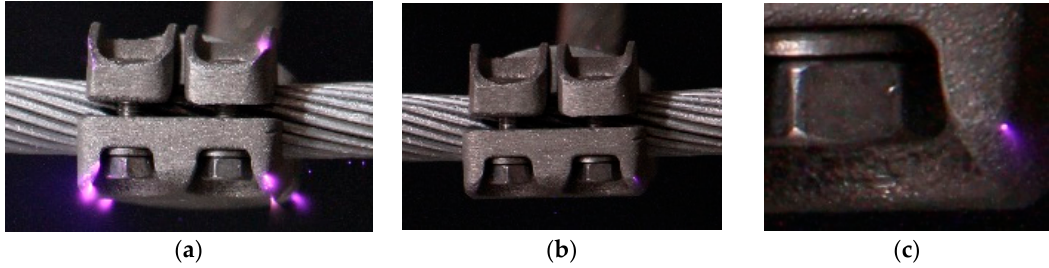
Figure 11. ( a ) ac corona at 77.75 kV RMS ; ( b ) ac corona near the extinction point at 58.5 kV RMS ; ( c ) Zoom